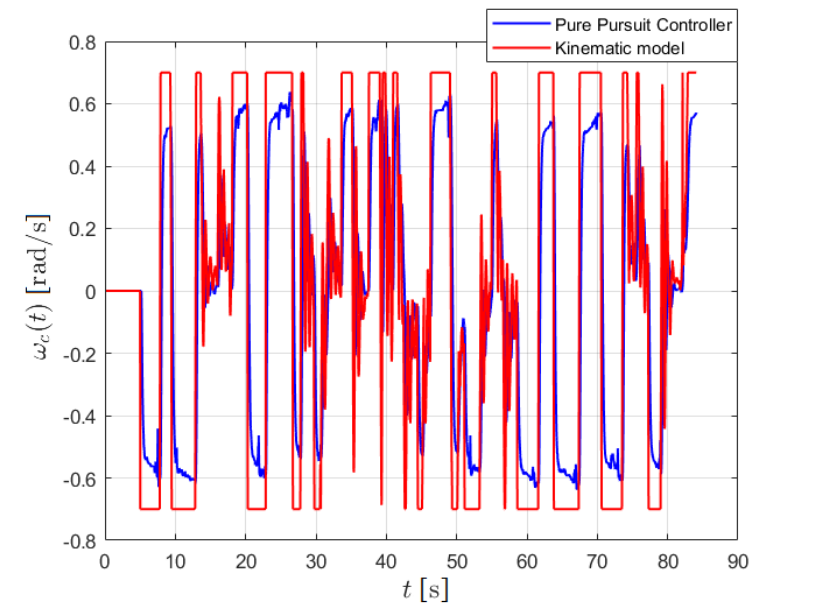
Figure 29. Angular velocity ω c ( t ) of the QBot 2e robot. The third generated map with the mapping of the path using the RRT star algorithm is presented below. Figures 31 and 32 present the linear and angular velocity of the robot. They were determined on the basis of odometric data and the kinematic model.